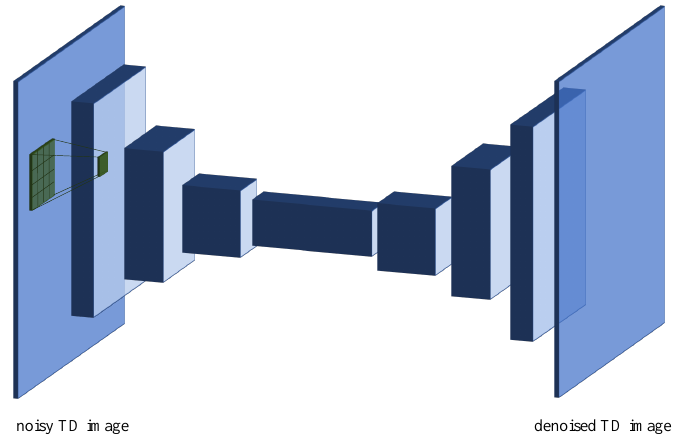
Figure 4. Diagram of the Convolutional Denoising Autoencoder (CDA). The noisy TD image is given as input and processed by a stack of convolutional layers, which detect increasingly more complex features in the signal that are then used by the decoder to produce a denoised TD